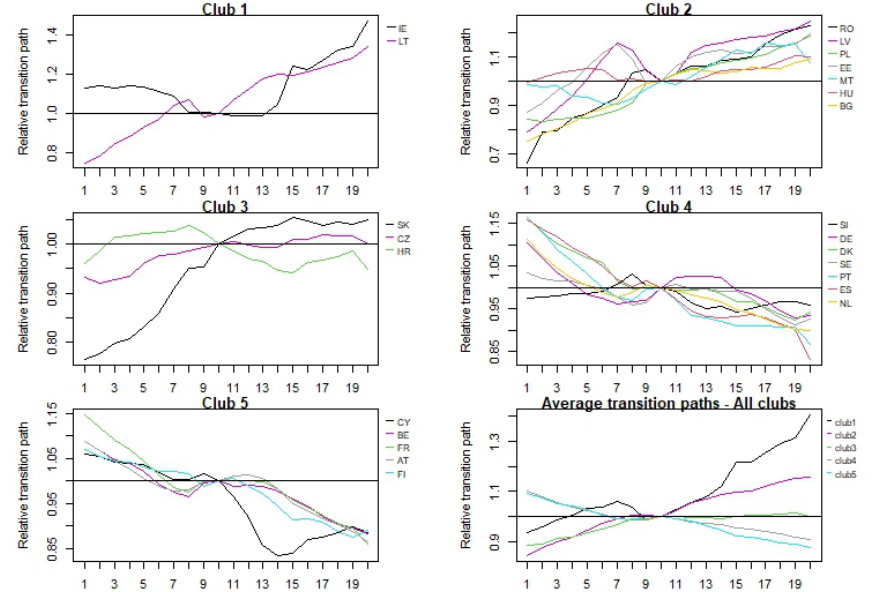
Figure A1. Convergence clubs—long-run